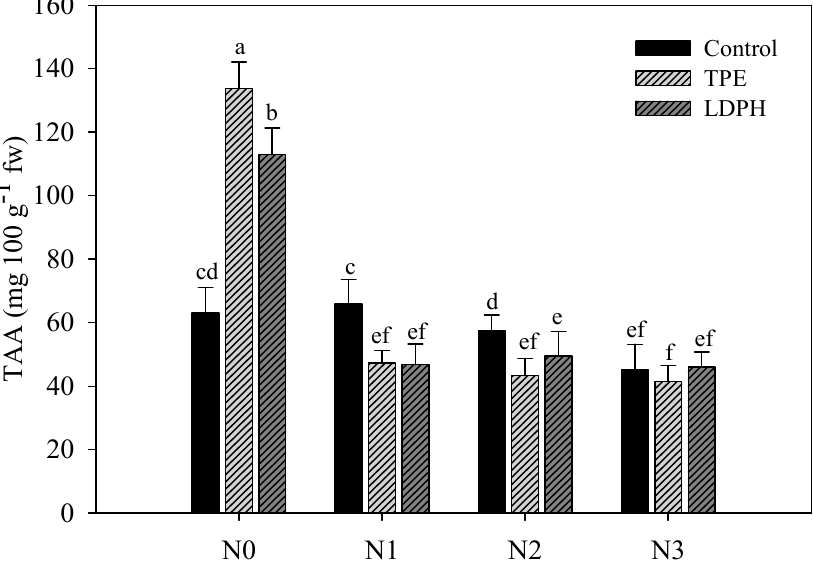
Figure 2. Total ascorbic acid (TAA) in relation to N fertilization rates (N0 = 0, N1 = 60, N2 = 80, and N3 = 100 kg ha –1 ) and biostimulant application (Control, tropical plant extract (TPE): Auxym and legume-derived protein hydrolysate (LDPH): Trainer). Different letters indicate significant differences at p ≤ 0.05.